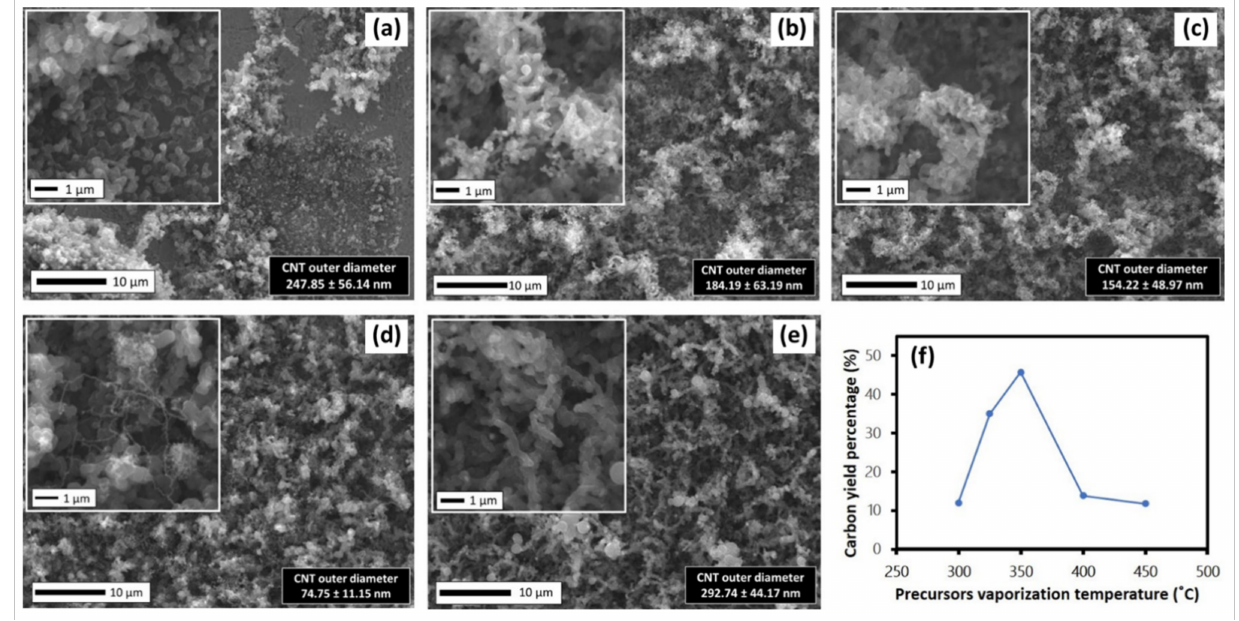
Figure 7. SEM images of samples synthesized at various precursor vaporization temperatures of ( a ) 300, ( b ) 325, ( c ) 350, ( d ) 400 and ( e ) 450 ◦ C, and ( f ) carbon yield